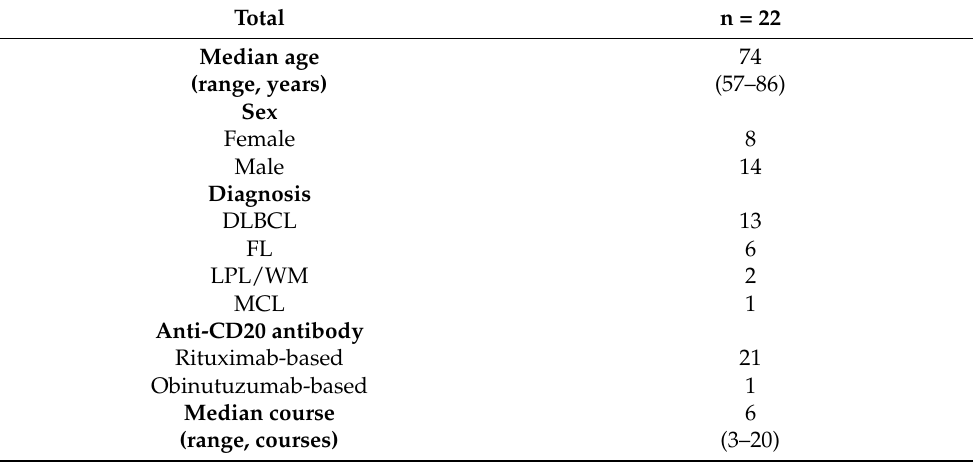
Table 1. Patient